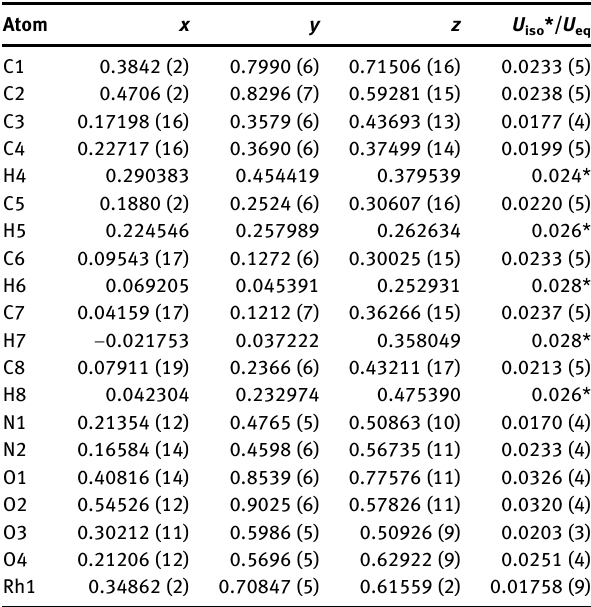
Table  : Fractional atomic coordinates and isotropic or equivalent isotropic displacement parameters (Å 